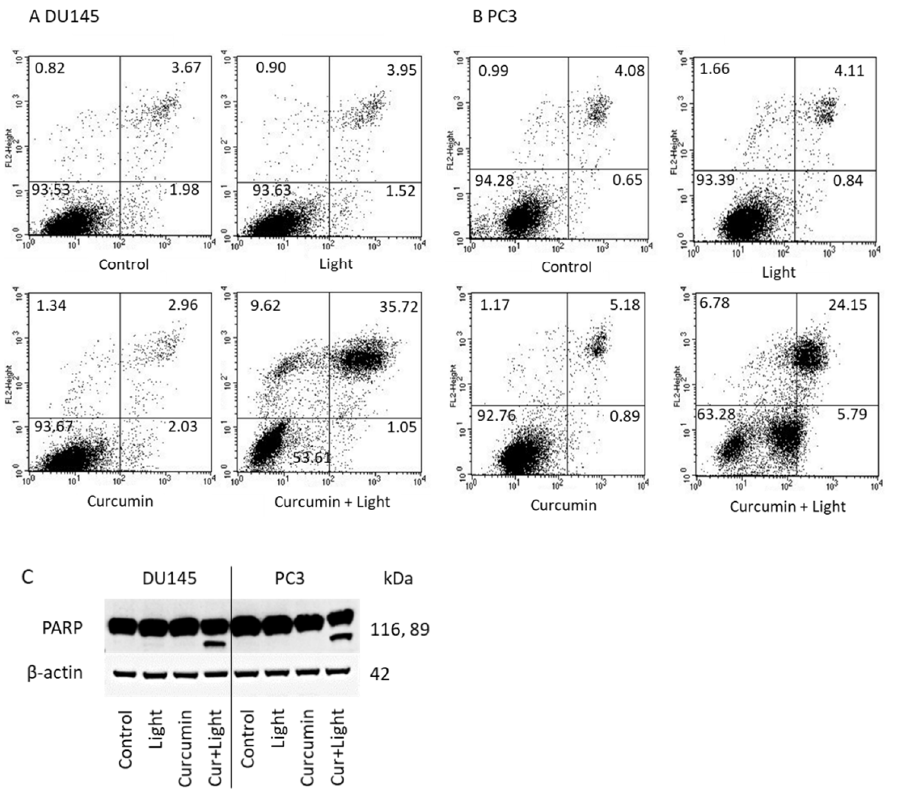
Figure 4. Induction of apoptotic events. DU145 ( A ) and PC3 ( B ) prostate cancer cells were incubated with visible light alone (5 min at 1.65 J/cm 2 ) or 0.2 μ g/mL curcumin alone for 24 h or were irradiated in the presence of curcumin (curcumin + light). Controls were incubated without curcumin or light. Early and late apoptosis was evaluated as indicated in methods. Dot blots of one representative test of three are shown. ( C ): PARP expression in DU145 and PC3 cells in the presence of visible light, curcumin, or curcumin + light (Cur + Light). Controls remained untreated. One representative result is shown.